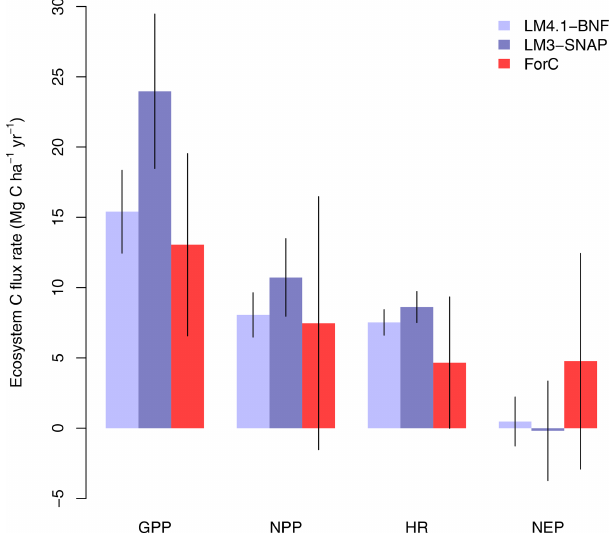
Figure 8. Simulated gross primary production (GPP), net primary production (NPP), heterotrophic respiration (HR), and net ecosys- tem production (NEP) by LM4.1-BNF and LM3-SNAP compared to the ForC database. Simulated data are averaged over the last 100 of the 300 years of simulation to reflect the data which are from mature forests. Error bars indicate 2 standard